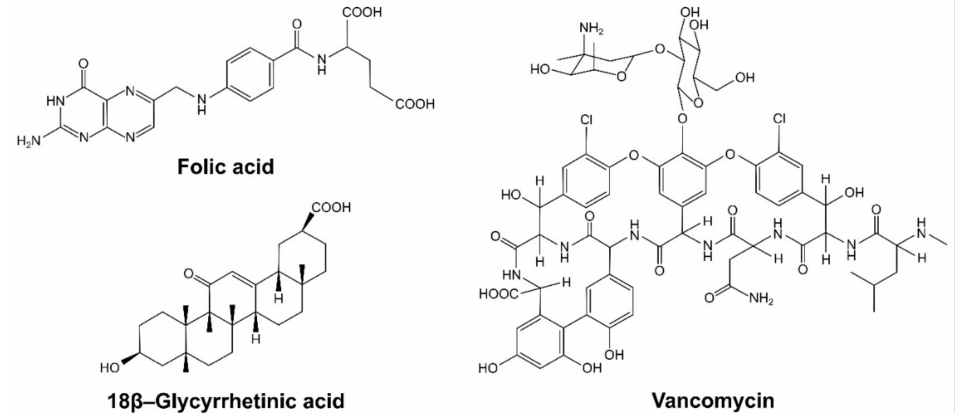
Figure 5. The structures of the biocompounds used in the